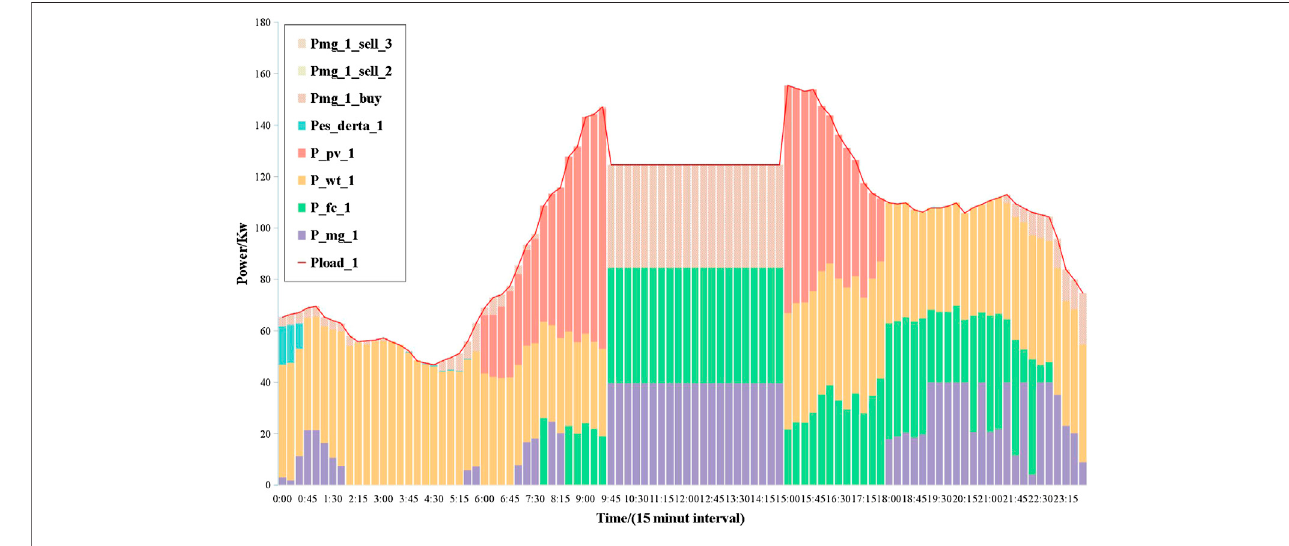
FIGURE 7 | Power balance of MG1.